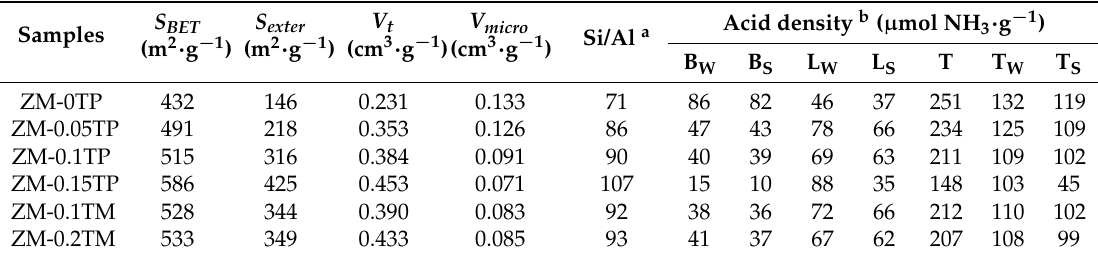
Table 2. Textural and acid properties of the zeolite